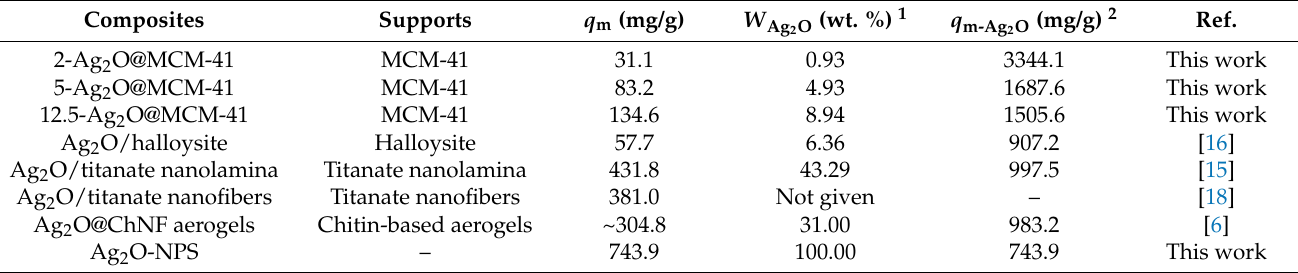
Table 2. Comparison of I − adsorption capacities on various Ag 2 O-based